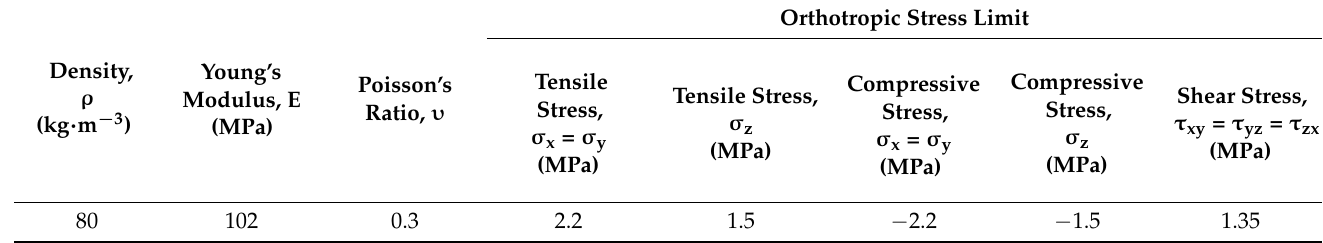
Table 3. Composite PVC Foam material parameters [35].